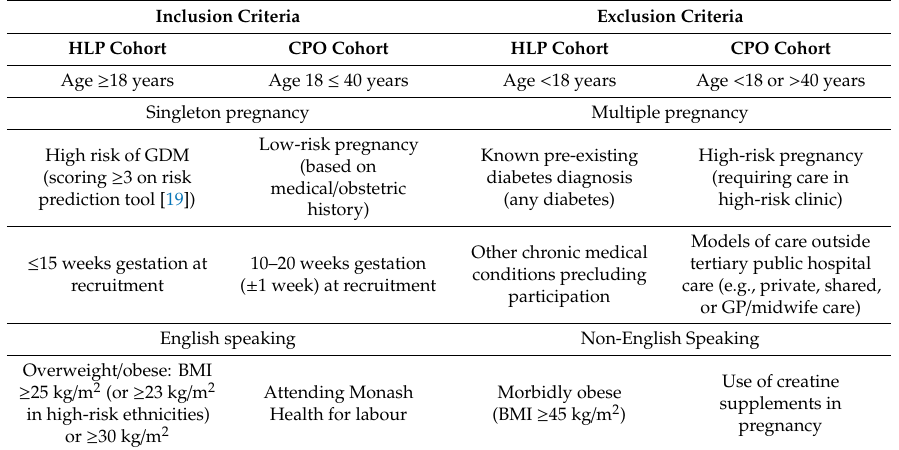
Table 1. Criteria for the inclusion and exclusion of participants in the HLP and CPO